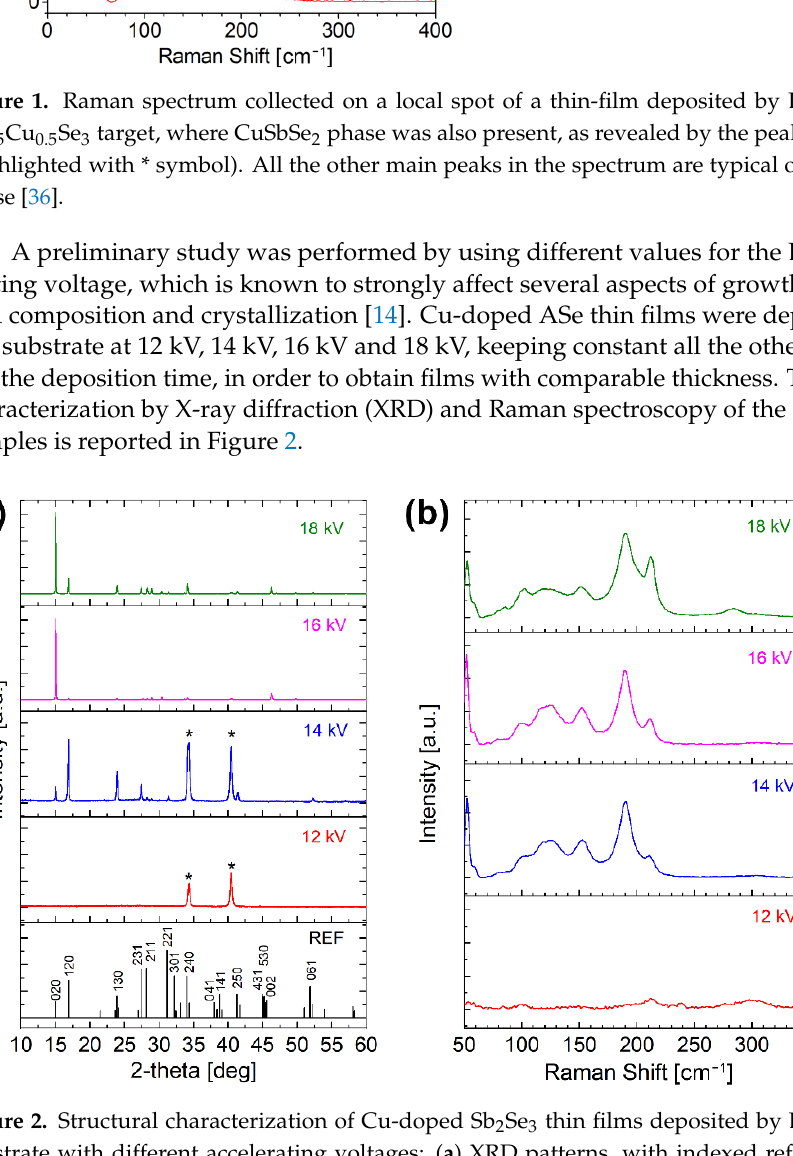
Figure 2. Structural characterization of Cu-doped Sb 2 Se 3 thin films deposited by LT-PED on Mo substrate with different accelerating voltages: ( a ) XRD patterns, with indexed reference (JCPDS 15–0681) for undoped Sb 2 Se 3 at the bottom (* indicates Mo substrate); and ( b ) Raman spectra.